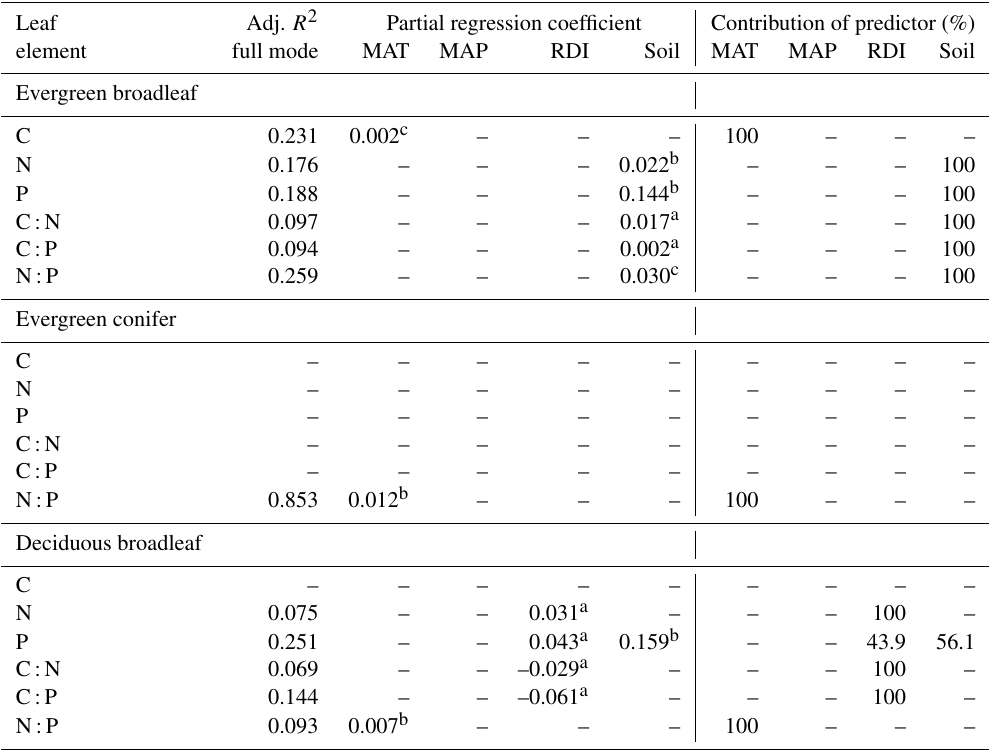
Table A5. Model summary for the stepwise multiple regression (SMR) of leaf element concentrations of different functional types on the climatic and soil variables (MAT, MAP, RDI, soil element and ratio). Leaf Adj. R 2 Partial regression coefficient Contribution of predictor (%) element full mode MAT MAP